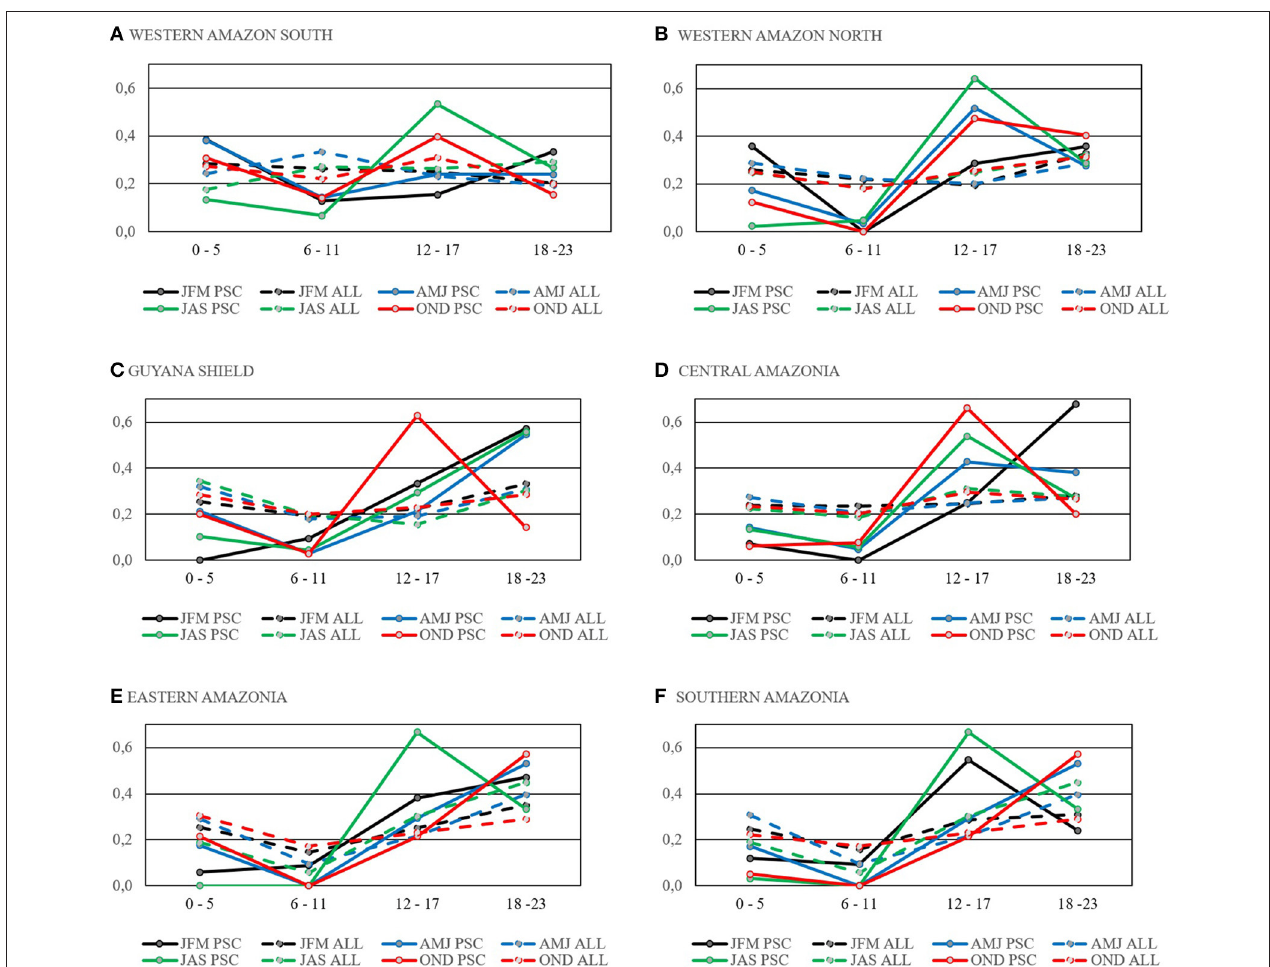
FIGURE 7 | Relative frequency of storms in the daily cycle identified in subset 1 (ALL) and subset 4 (PSC) for each quarter (JFM, AMJ, JAS, OND). (A) WAS; (B) WAN; (C) GS; (D) CA; (E) EA, and (F) SA. Dashed lines refer to ALL and full lines to PSC. Black stands for JFM, blue for AMJ; green for JAS and red for